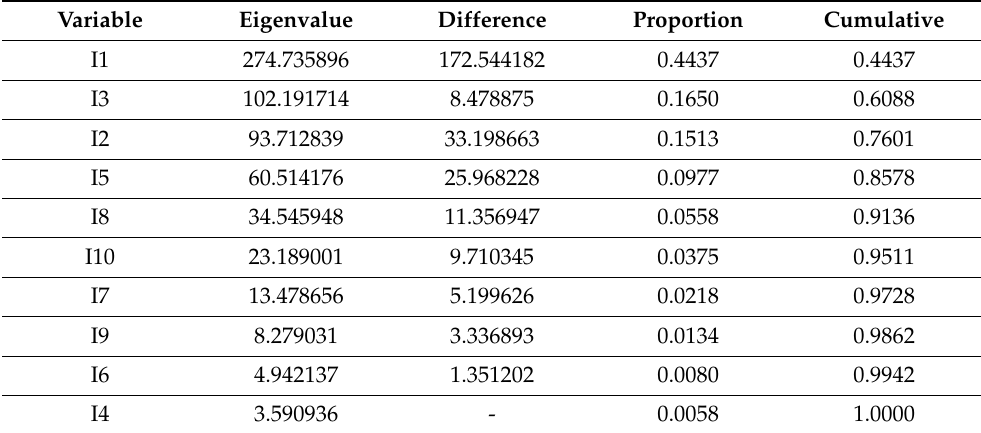
Table 4. Eigenvalues of the covariance matrix.